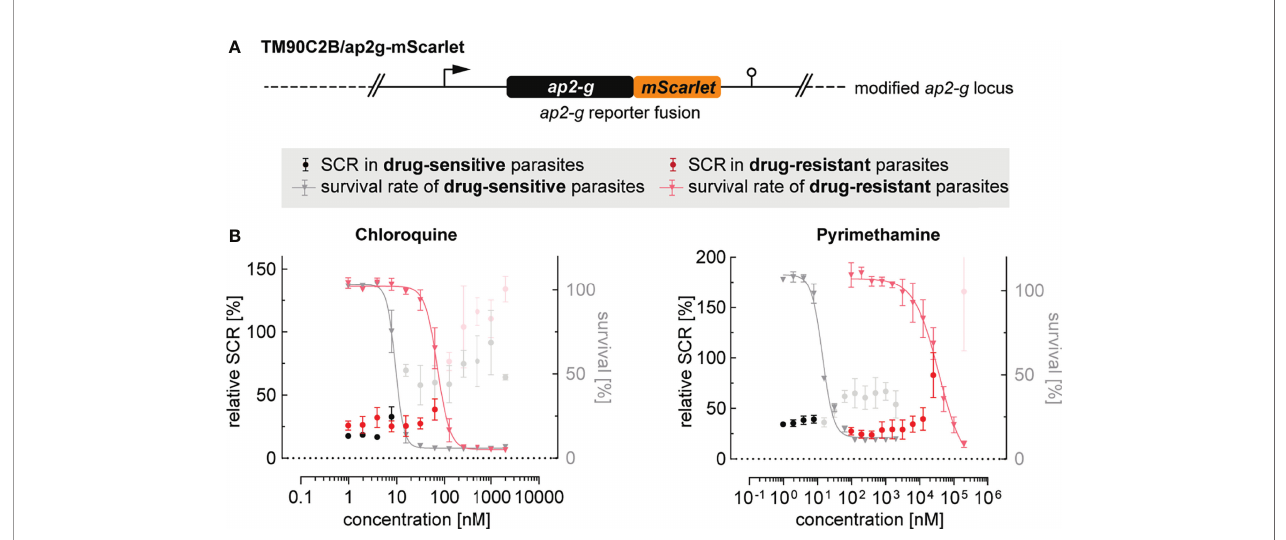
FIGURE 5 | Effect of antimalarials on SCR in drug-resistant parasites. (A) Schematic of the modi fi ed ap2-g locus in multidrug-resistant TM90C2B/ap2g-mScarlet parasites. (B) Trends towards increased sexual commitment are linked to growth-inhibiting concentrations of Chloroquine and Pyrimethamine in drug-sensitive as well as in drug-resistant parasite lines. For NF54/ap2g-mScarlet, mean parasite survival rates and SCRs are indicated by grey triangles and black bullets, respectively (values adopted from Figure 2A ). For drug-resistant TM90C2B/ap2g-mScarlet parasites, mean parasite survival rates and SCRs are indicated by light red triangles and red bullets, respectively. Grey and light red bullets represent SCRs at compound concentrations above the IC50. Values are normalized to the corresponding control conditions (-SerM for SCR) and (-SerM/choline for survival). n=3; error bars represent the standard error of the